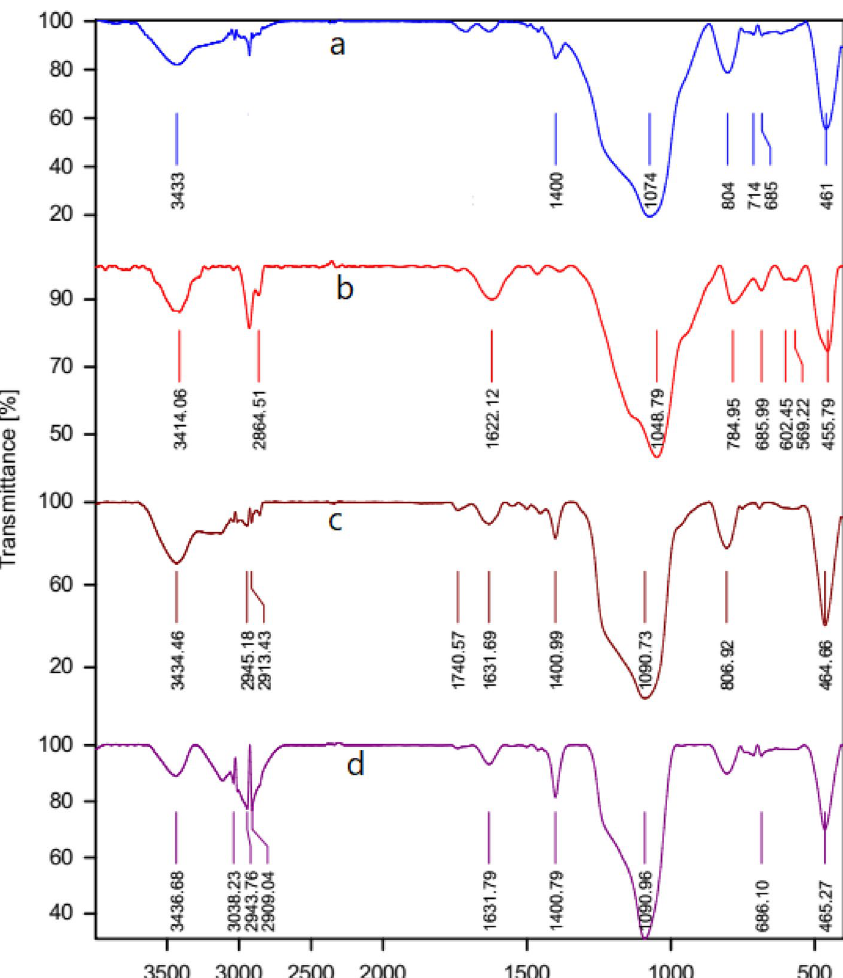
Figure 11. The FT-IR spectrum of HMS (a), HMS/Pr (b), HMS/Pr-PTSC (c) and HMS/Pr-PTSC-Cu